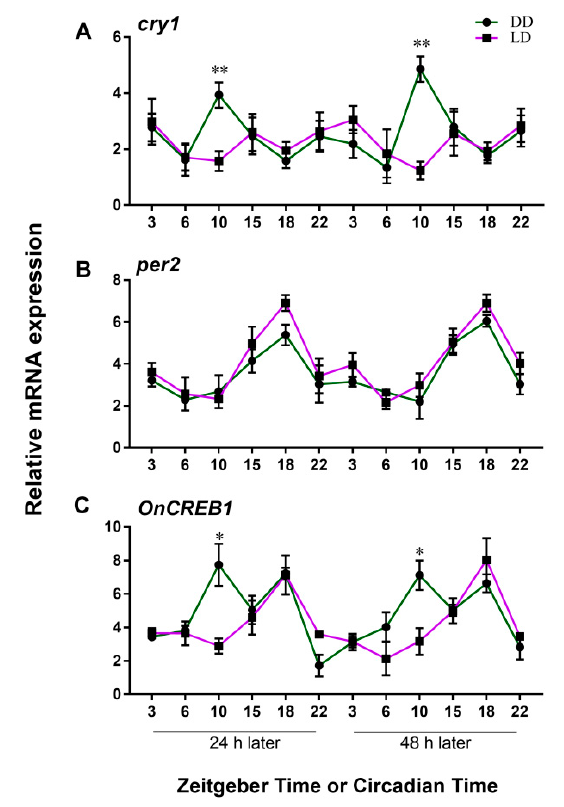
Figure 7. Temporal expression patterns of cry1 , per2 , and OnCREB1 in Onchidium reevesii under LD and DD cycles. ( A ) Expression of cry1 . The expression of cry1 showed a significant e ff ect based on lighting conditions (light, p < 0.05; time, p > 0.05). Cry1 expressed irregularly in LD conditions ( cry1 LD, p > 0.05) and expressed rhythmically in DD conditions ( cry DD, p < 0.05), with peak expression at CT 10 (Bonferroni’s post hoc analysis, ** p < 0.01 for ZT 10 vs. CT 10 at 24 and 48 h). ( B ) Expression of per2 . Quantitative analysis of per2 revealed a significant e ff ect of sampling time (time, p < 0.05) but not lighting conditions (light, p > 0.05). The per2 transcripts of LD and DD cycled in phase with each other, with a peak expression time point at CT / ZT 24. ( C ) Temporal profiles of OnCREB1 expression sampled in LD and DD. There was a significant e ff ect of lighting condition × sampling time on OnCREB1 expression ( p < 0.05). OnCREB1 has two peak expressions at CT 10 and CT 18 under constant darkness, and one peak expression at ZT 18 under the light–dark cycle (Bonferroni post hoc analysis, * p < 0.05 for ZT 10 vs. CT 10 at 24 and 48 h). Statistical analyses of all data were performed using two-way ANOVA with Bonferroni post hoc analysis for comparisons between groups. Values are means ± SEM ( n = 3 for ZT 3, 6, 10, 15, 18, 22 and CT 3, 6, 10, 15, 18, 22).